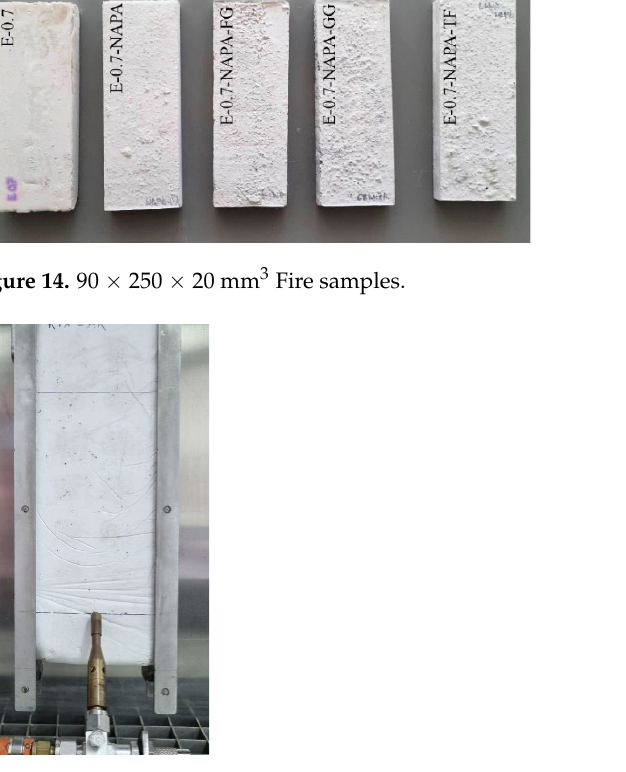
Figure 15. Flame position mark.